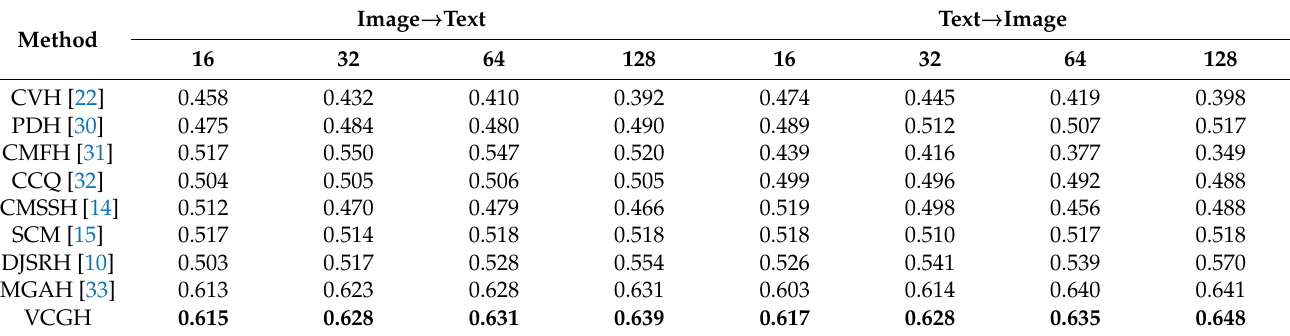
Table 2. The MAP scores of two retrieval tasks on the NUS-WIDE dataset with different lengths of hash codes. The best results are highlighted in